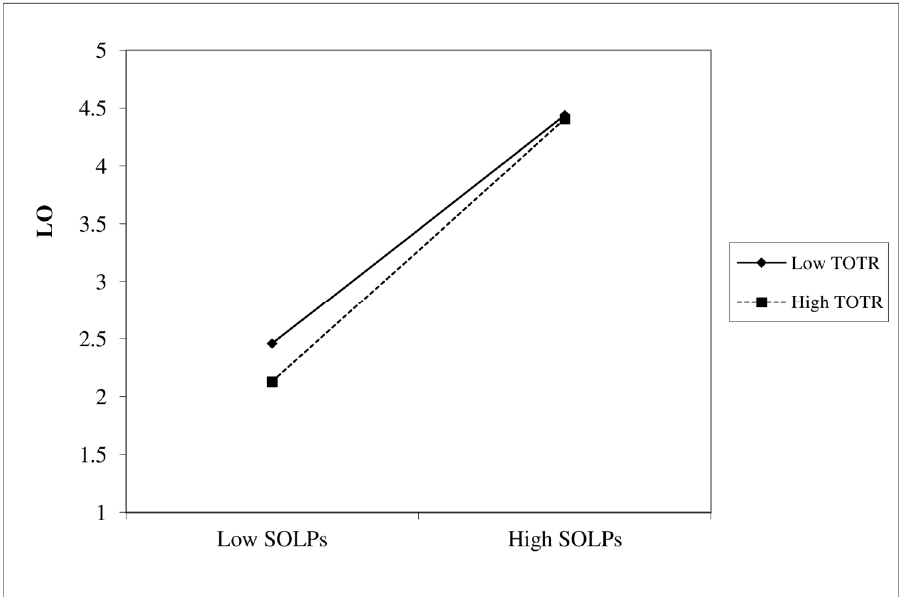
Figure 7. The moderating effect of TOTR on SOLPs and LO.